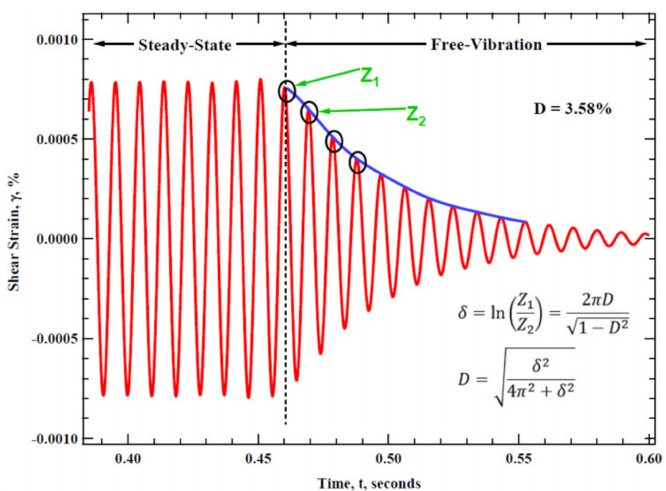
Figure 11. Determination of the material damping ratio from the free-vibration decay curve for a metal specimen